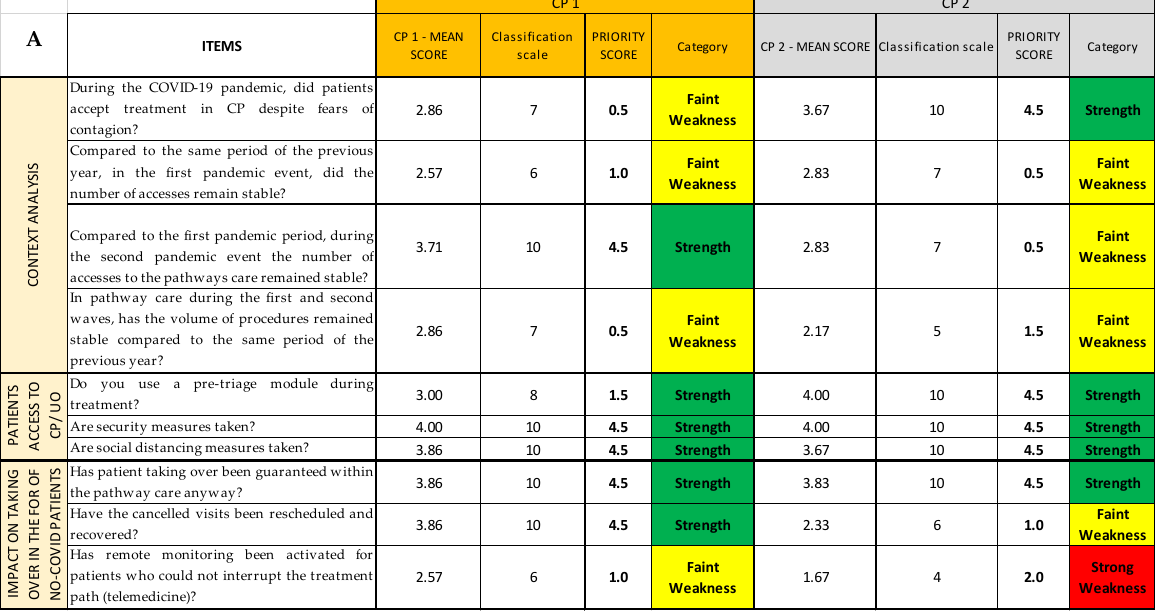
PRIORITY SCORE Category